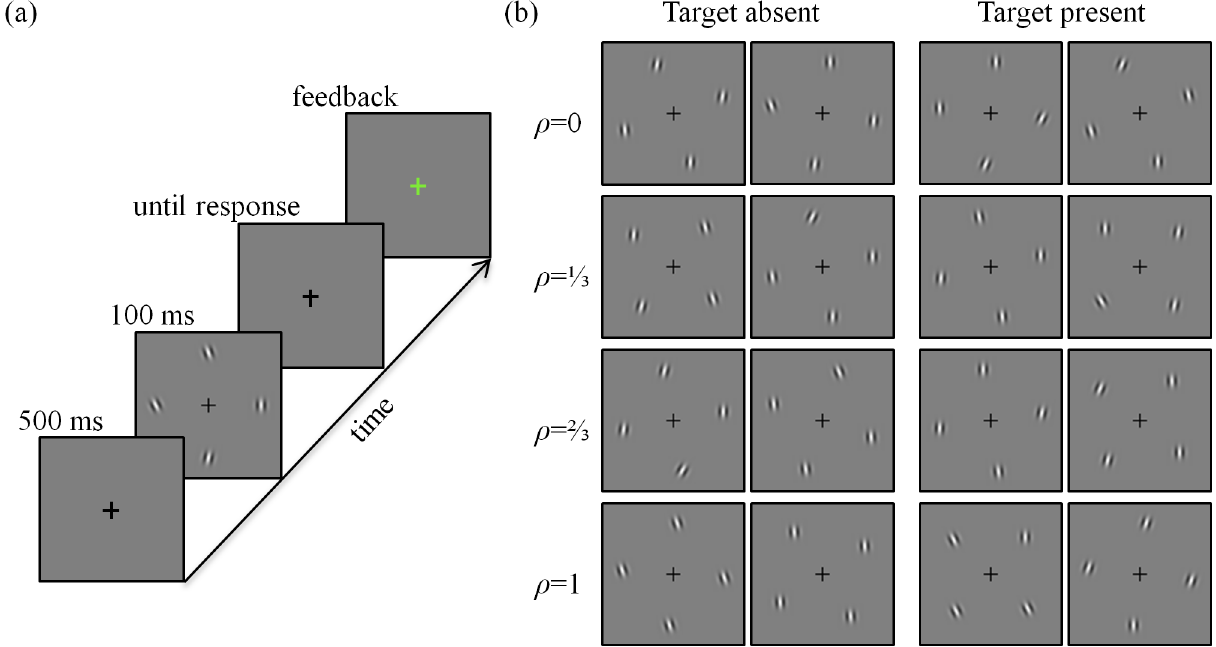
Fig 1. Experimental procedure and sample displays. (a) Time course of a trial, (b) Sample displays for each of the correlation coefficients used. In a given experimental session, only one value of ρ was